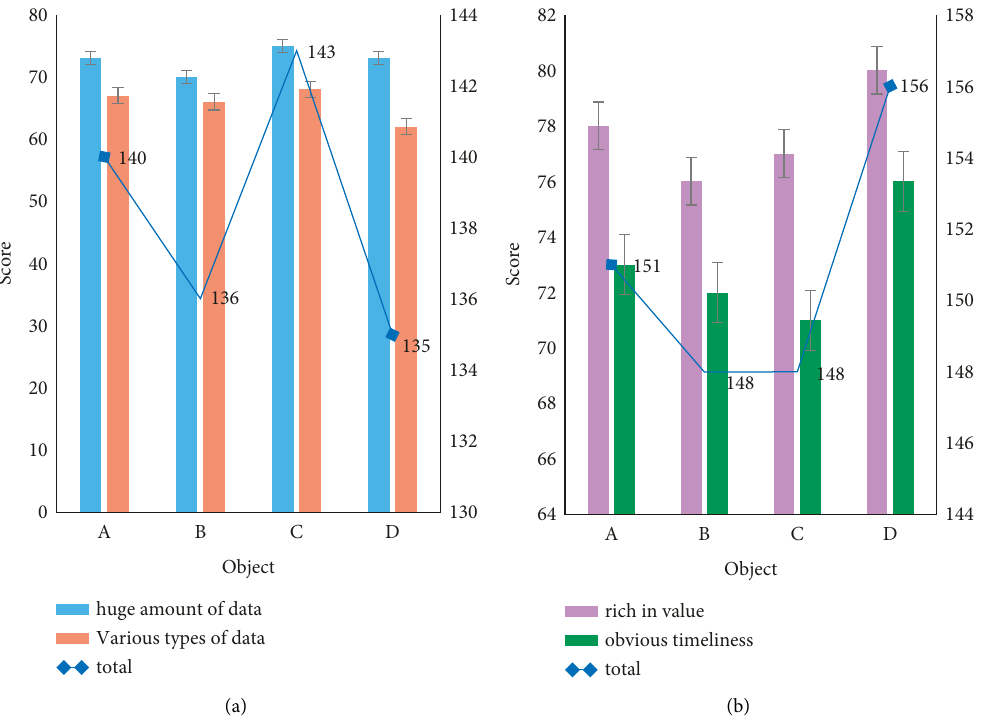
Figure 10: Traditional technologies and intelligent transportation systems manage traffic data. (a) Characteristics of traditional technologies in traffic management. (b) Characteristics of intelligent transportation systems in traffic management. Table 4: Efficiency after ITS application in supply chain management system. Analysis